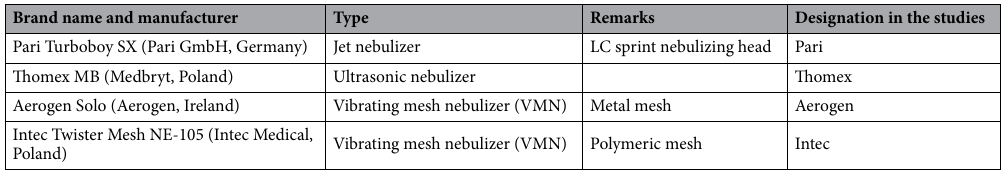
Table 2. Nebulizers used in the